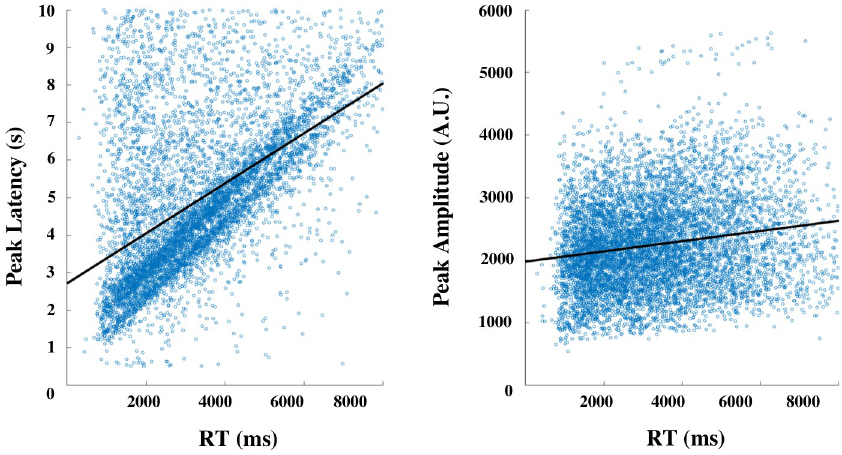
Fig 2. Scatter plots showing response time for every individual trial in the experiment by peak latency measurements (left) and peak task-evoked amplitude measurements (in arbitrary units: A.U.) (right). Black lines represent the least squares linear fit to the data. Peak latency, in particular, showed a striking relationship with response time, reflected in the diagonal band of data points.